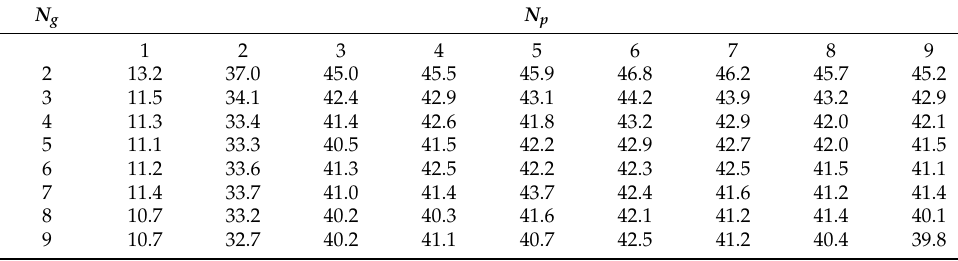
Table 3. Percentages of data sets with R P 1 ≥